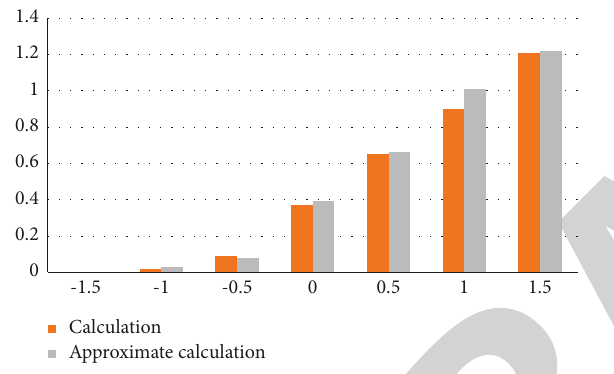
Figure 7: Contrast curve with approximate calculated integral